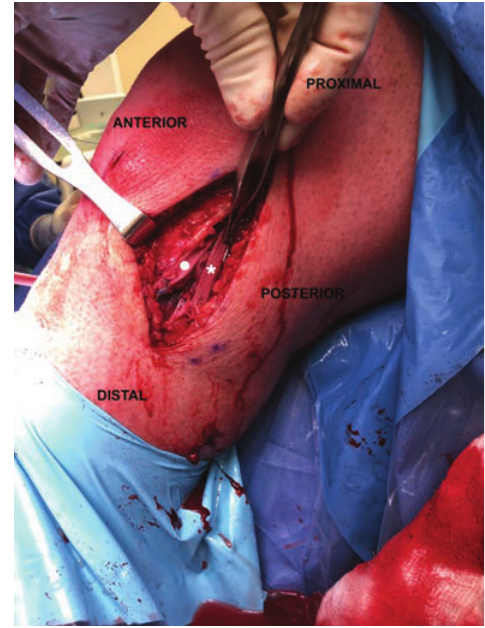
PLC repair of left knee with overlying Artelon Fig. 4: augmentation into proximal fibular (star) and tibial (circle) suture